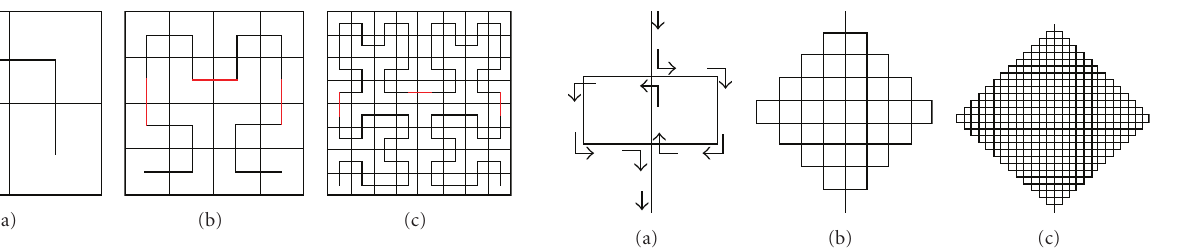
Figure 2: Peano curve (iteration 1, iteration 2, and iteration 3).